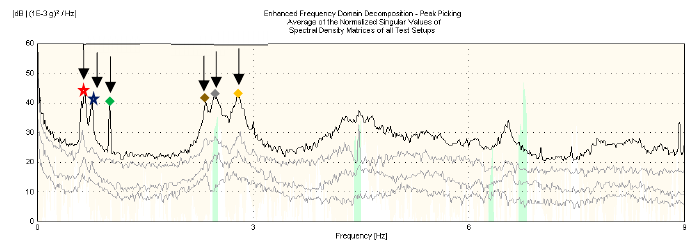
Figure 8. Ambient vibration test: normalized single values of spectral density matrices.